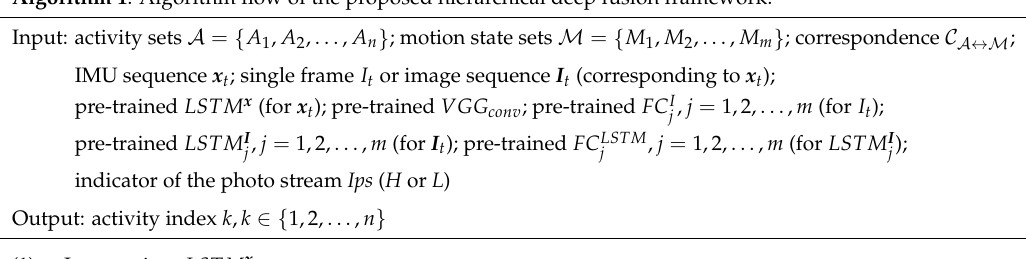
Algorithm 1 : Algorithm flow of the proposed hierarchical deep fusion